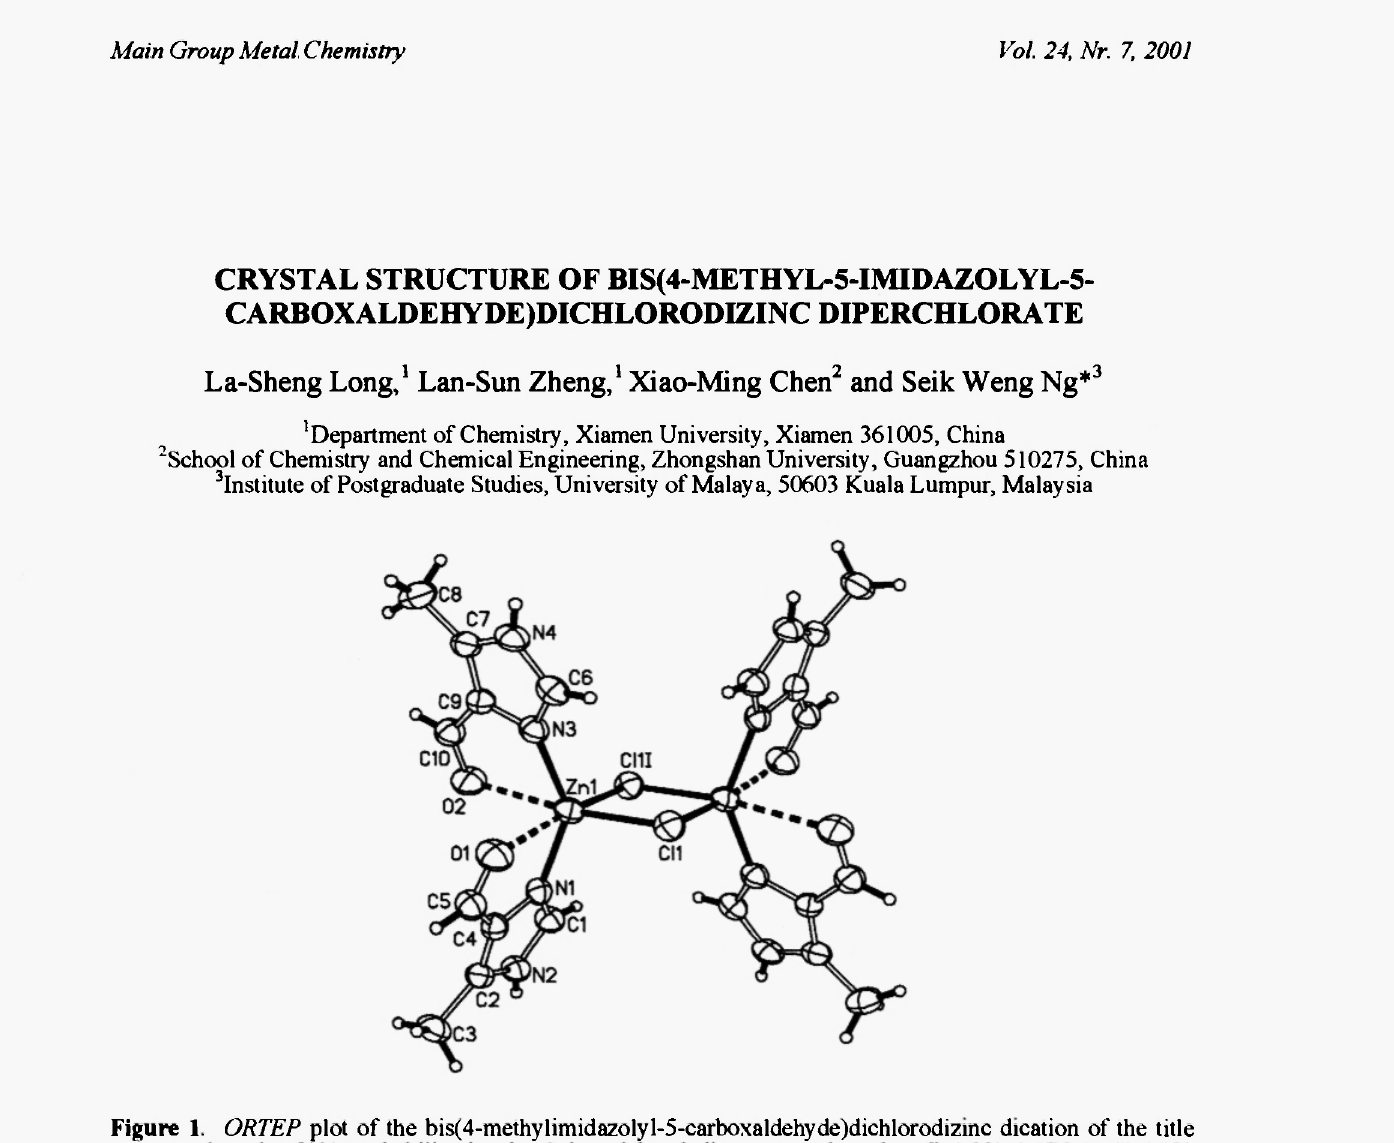
Figure 1. ORTEP plot of the bis(4-methylimidazolyl-5-carboxaldehyde)dichlorodizinc dication of the title compound at the 50% probability level. Selected bond distances and angles: Znl-Nl 1.976(4), Znl-N3 1.983(4), Znl-Ol 2.494(4), Znl-02 2.633(4), Znl-Cll 2.346(2), Znl-Cll/ 2.443(2) A; Nl-Znl-N3 140.8(2), Nl-Znl-Ol 73.4(1), Nl-Znl-02 79.2(1), Nl-Znl-Cll 107.4(1), Nl-Znl-Cll; 97.2(1), N3-Znl- 01 82.1(1), N3-Znl-02 71.0(1), N3-Znl-Cll 104.1(1), N3-Znl-Cll/ 105.3(1), 01-Znl-02 91.1(1), 01- Znl-Cll 93.3(1), Ol-Znl-Cll/ 170.5(1), 02-Znl-Cll 172.9(1), 02-Znl-Cll/ 85.9(1), Cll-Znl-Cll/ 90.6(1), Znl-CI 1-Znl/ 89.4(1)° Symmetry transformation: /= - χ, 1 - ν, 1